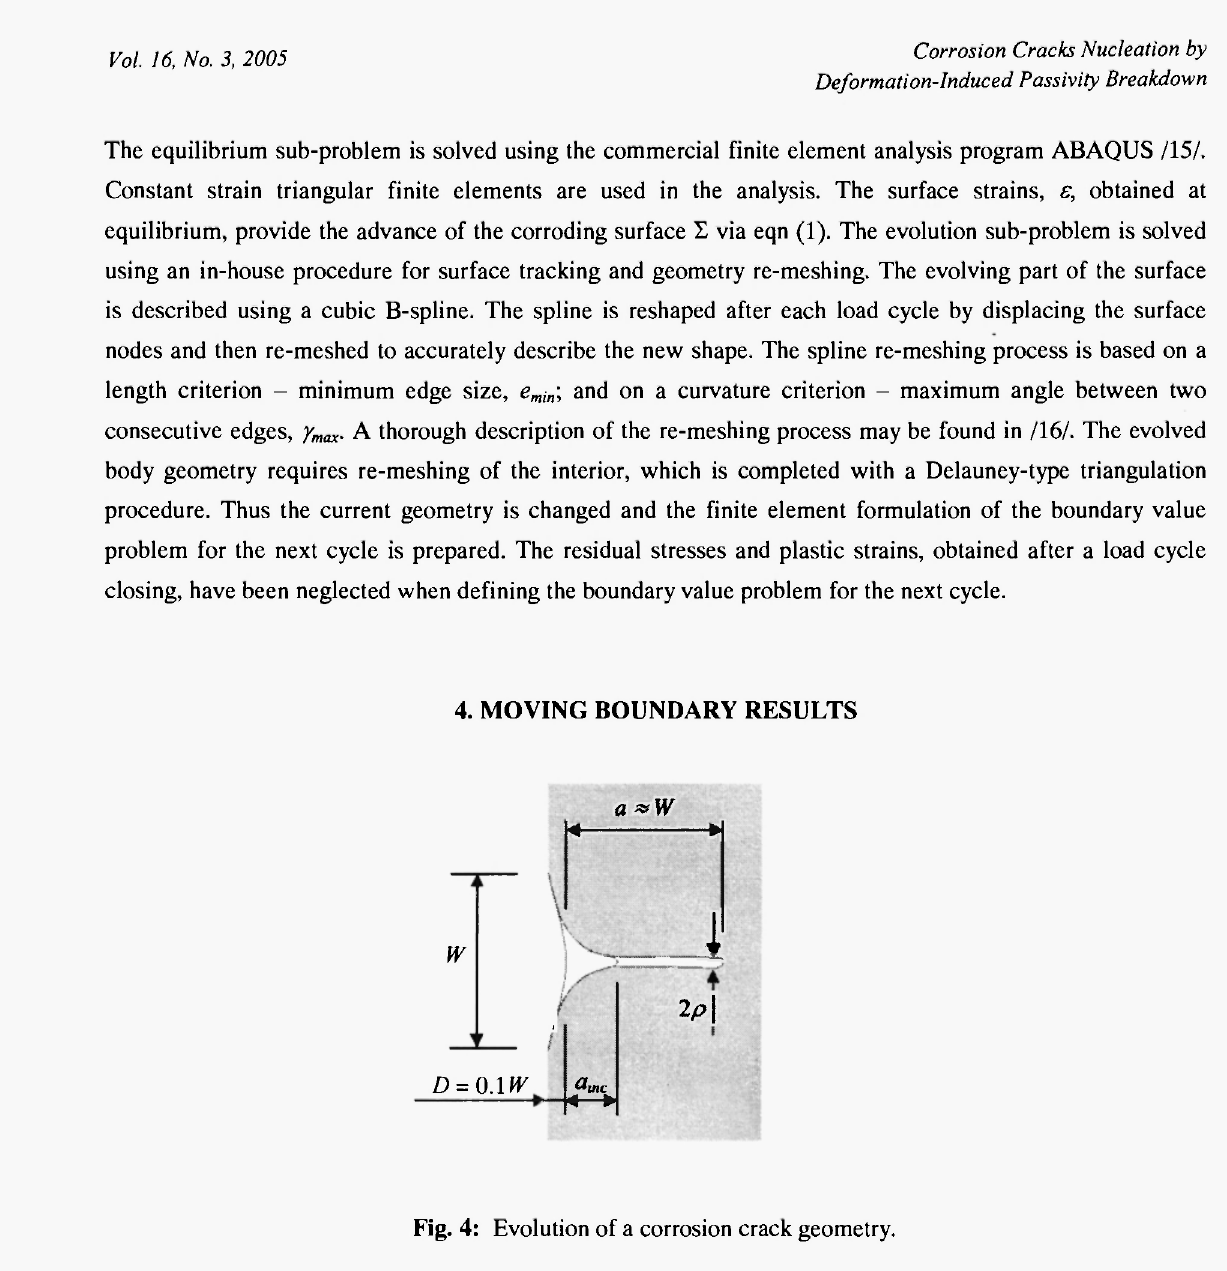
Fig. 4: Evolution of a corrosion crack